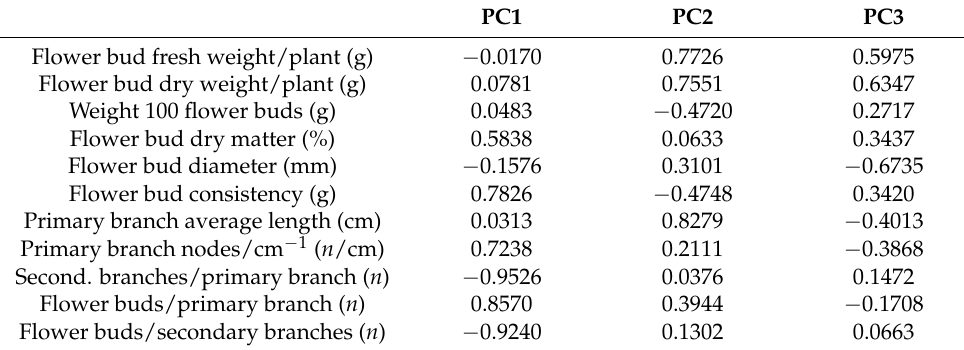
Table 5. Factor weights of properties on the three principal components.